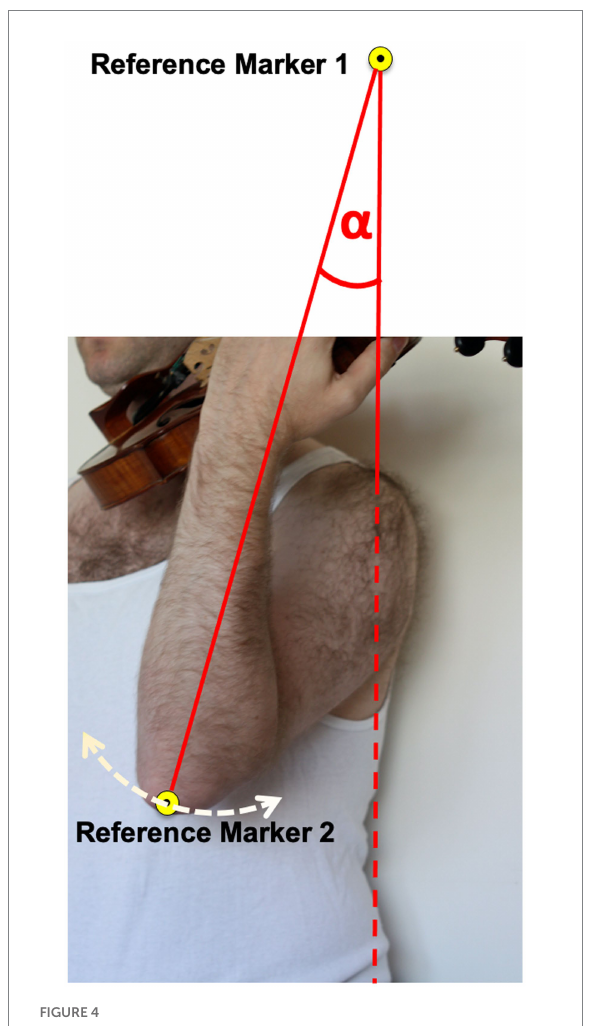
FIGURE 4 Schematic illustration of Reference Markers 1 and 2, and Reference Angle α